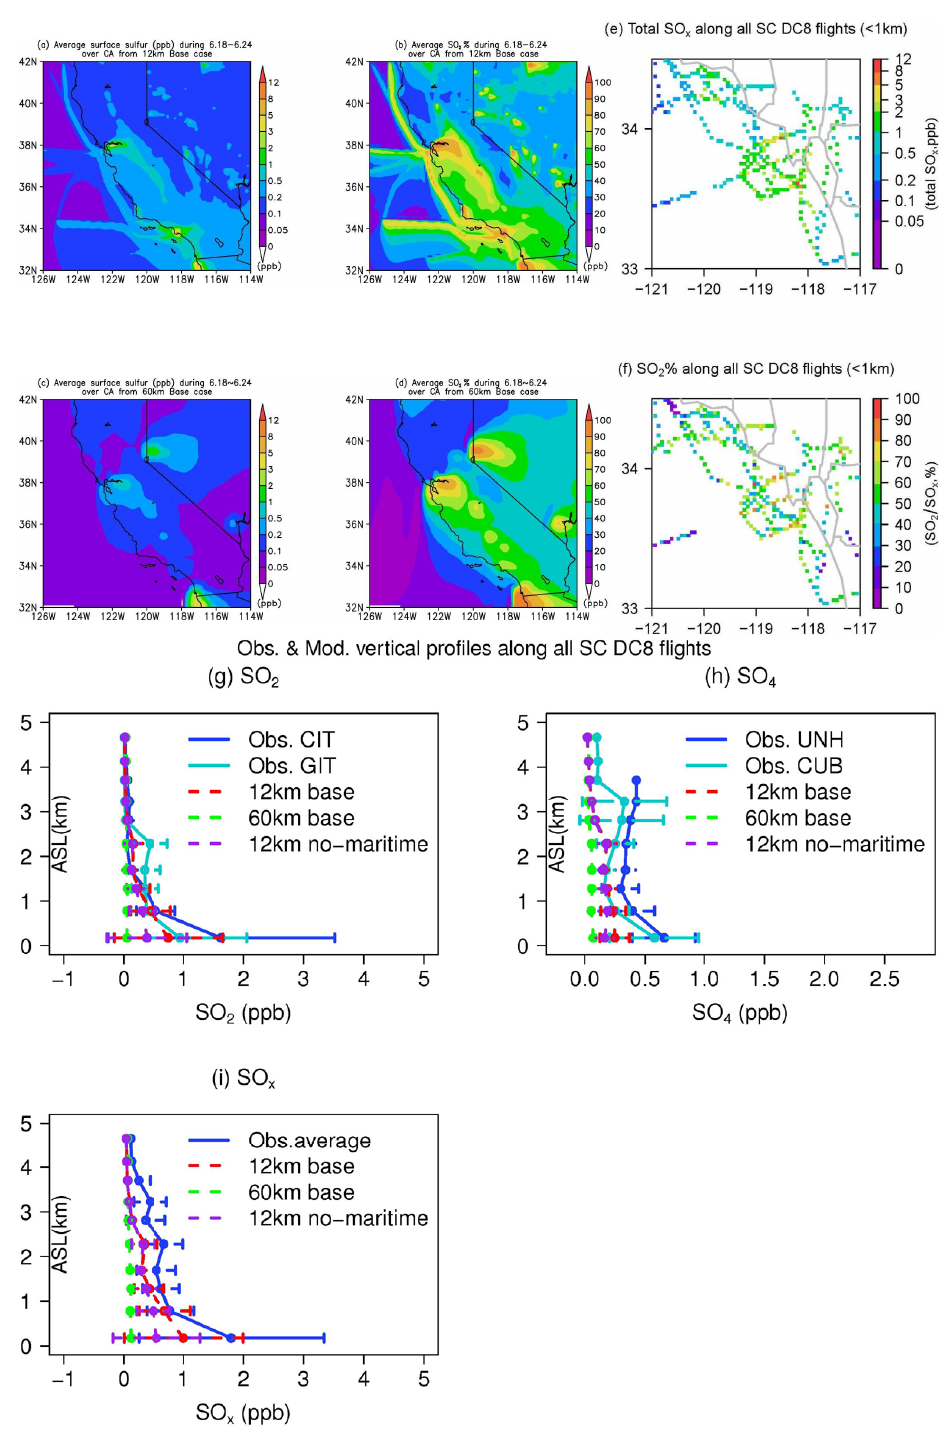
Fig. 7. The 24-h average surface (a, c) total SO x and (b, d) SO 2 % from 12km (a–b) and 60km (c–d) base simulations during the flight week; Observed (e) total SO x and (f) SO 2 % along all SC flights below 1km. Observed and modeled (g) SO 2 (h) SO 4 and (i) SO x vertical profiles along all SC flights (averaged every